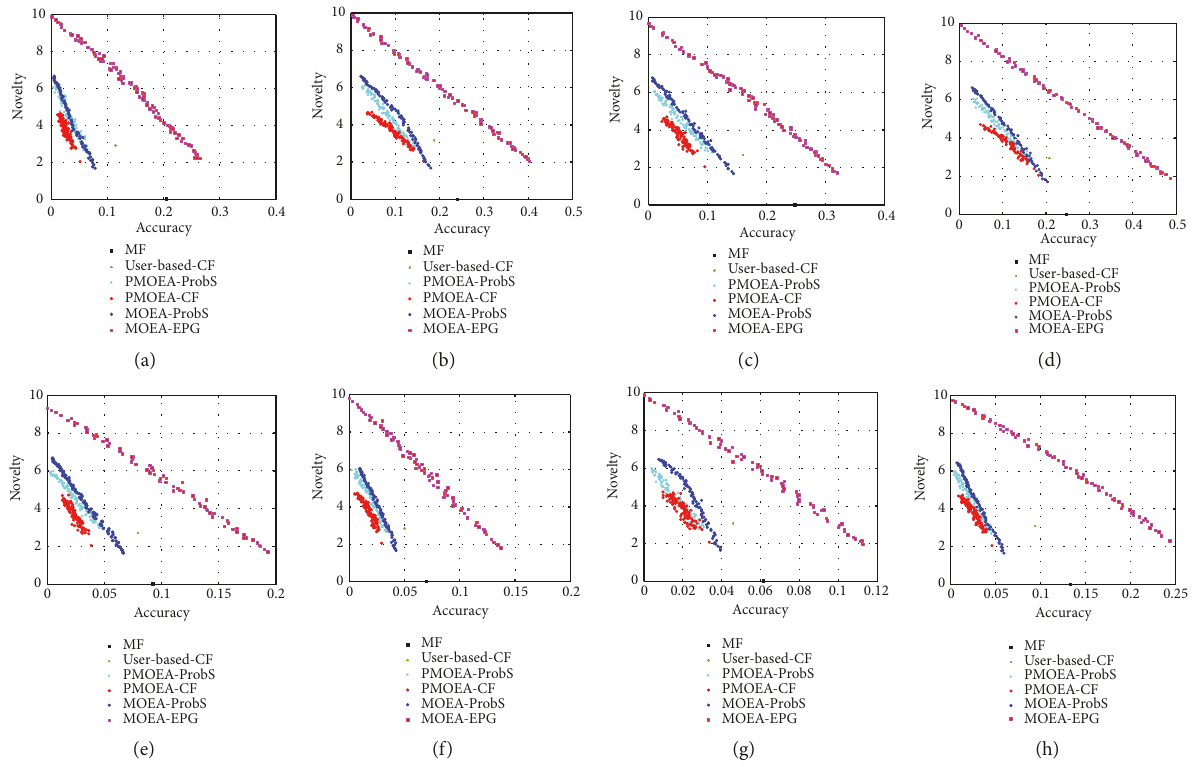
Figure 9: Final recommendation results of comparison algorithms under the accuracy-noveltyspace for (a) Movielens 1, (b) Movielens 2, (c) Movielens 3, (d) Movielens 4, (e) Netflix 1, (f) Netflix 2, (g) Netflix 3, and (h) Netflix 4.